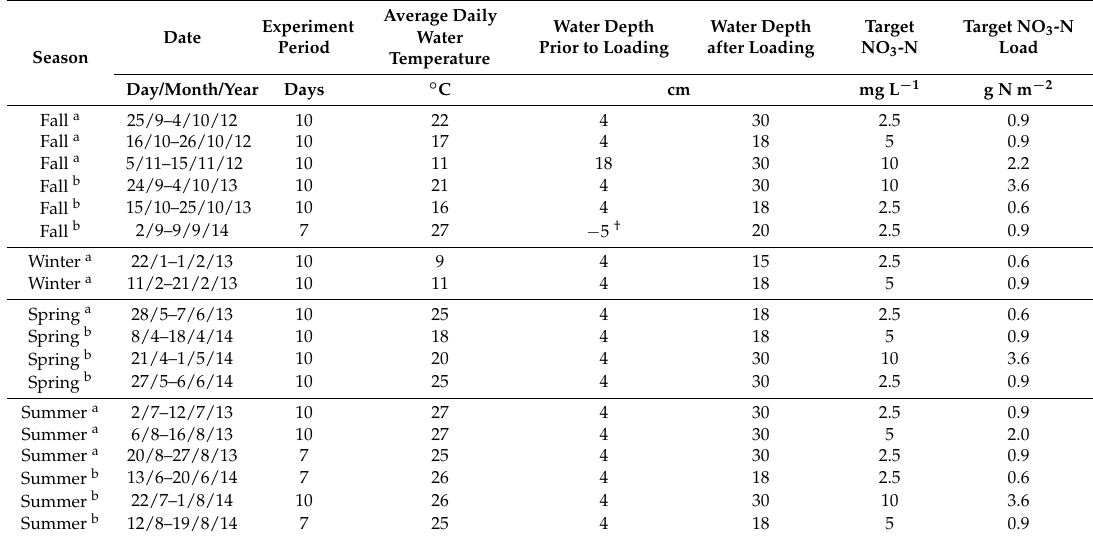
Table 1. Summary of wetland mesocosm batch experiments